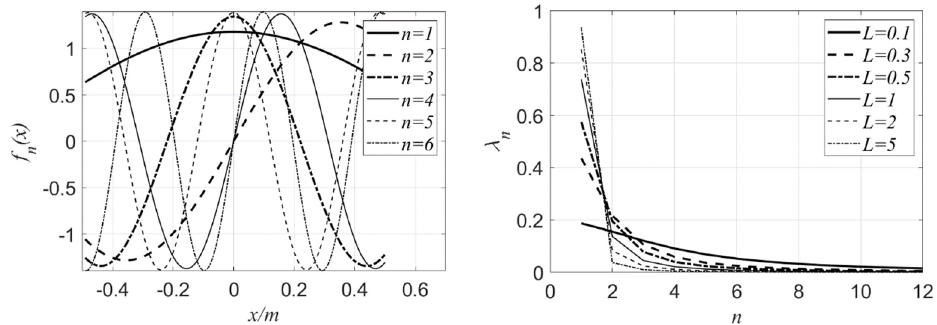
Figure 1. Eigenfunctions ( left ) and eigenvalues ( right ) of autocovariance matrix in the case of 1D. After the eigenfunctions and eigenvalues of 1D random field are obtained, the autocorrelation function can be obtained based on Equation (3); i.e., ∑ λ k f k ( x 1 ) f k ( x 2 ) . When the length of 1D random field is 1m and the correlation length L is 0.3 m, C ( x 1 , x 2 ) is displayed in Figure 2. Figure 2a is the autocorrelation kernel function represented by Equation (4), and Figure 2b–d are the C ( x 1 , x 2 ) obtained with K-L expansion, respec- tively, when the truncation number m is taken as 4, 8, and 12, whereby C ( x 1 , x 2 ) = m ∑ λ k f k ( x 1 ) f k ( x 2 ) . k = 1